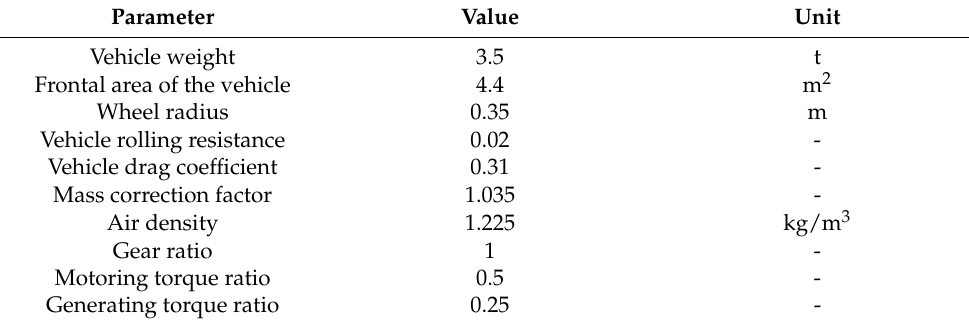
Table 3. Artemis driving cycle